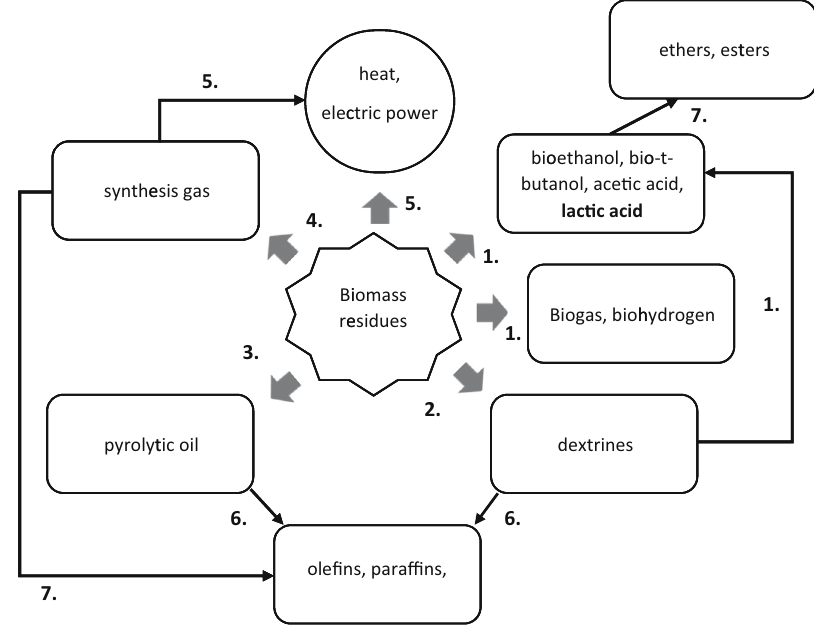
Figure 1: The idea of components or energy recovery from bioprocesses waste or by - product. Descriptors: ( 1 ) fermentation, ( 2 ) hydrolysis, ( 3 ) pyrolysis, ( 4 ) outgasi fi cation, ( 5 ) combustion, ( 6 ) reforming ( hydro - reforming ) , and ( 7 ) catalytic